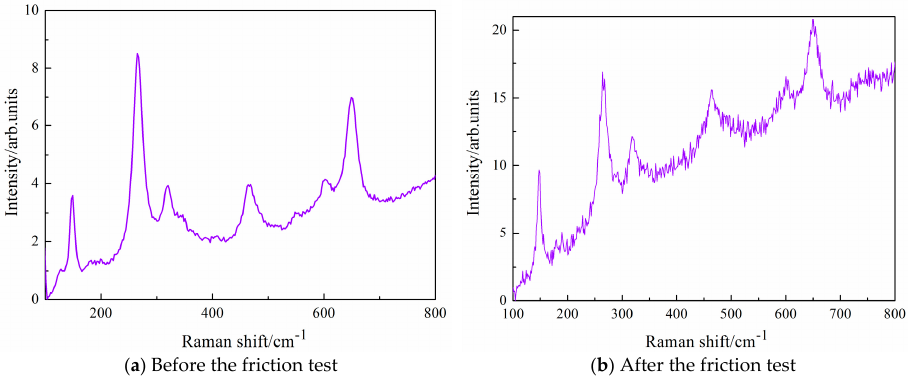
Figure 10. Raman spectra of ZrO 2 ball: ( a ) before the friction test; ( b ) after the friction test.